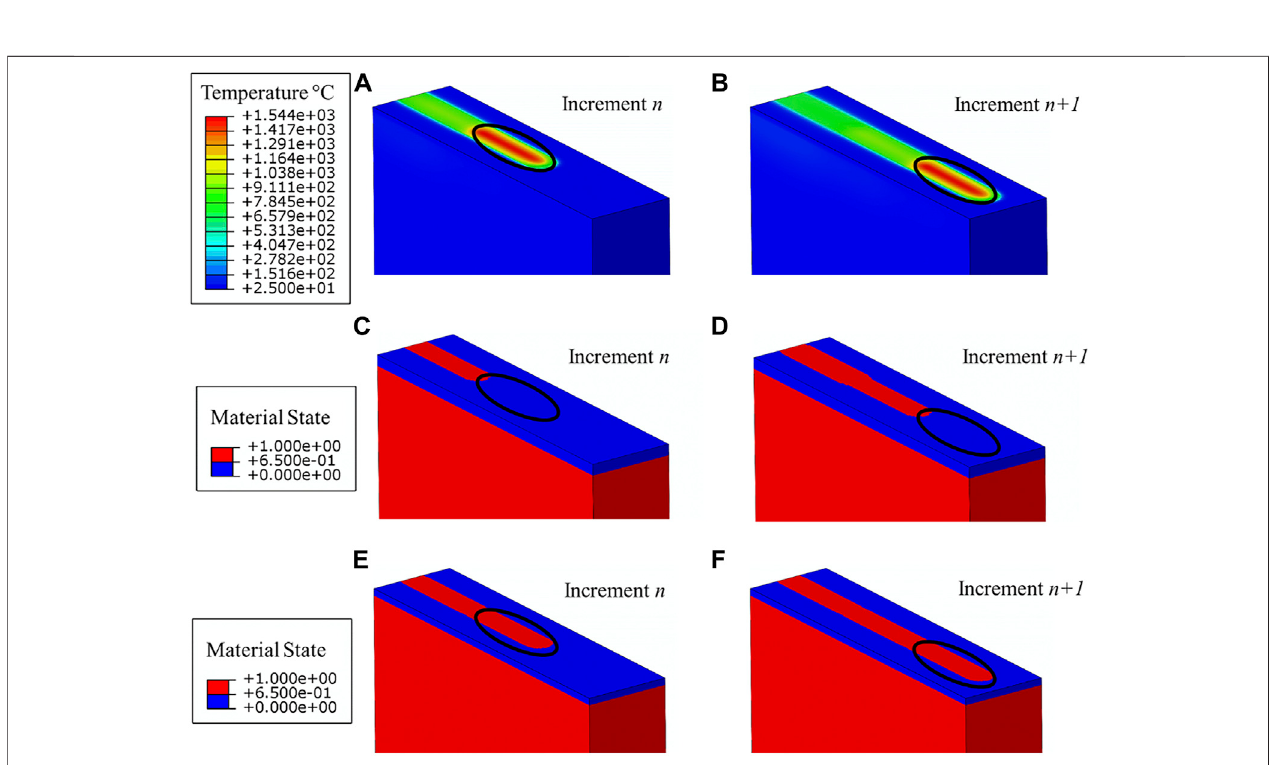
FIGURE 5 | Nodal temperatures are shown in increments (A) n and (B) n + 1. The material state transition showing the lag effect in increment (C) n and (D) n + 1. The modi fi ed material statetransitionisshown inincrement (E) n and (F) n + 1withoutlag.Powder state isshown inblueand liquid/solidstate isshown inred.Theblack ellipsoid shows the location of the applied